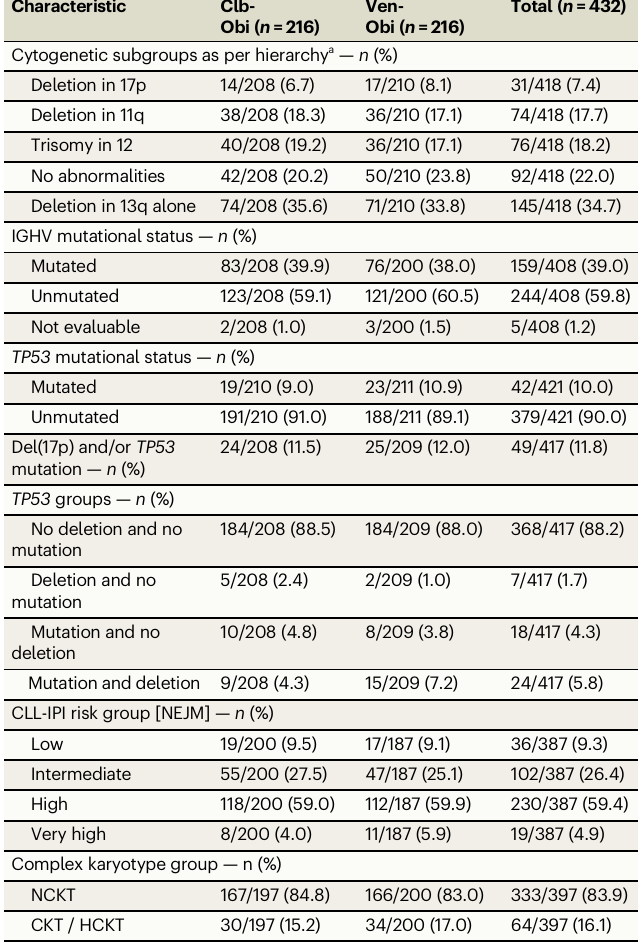
Table 2 | CLL genetic characteristics at baseline